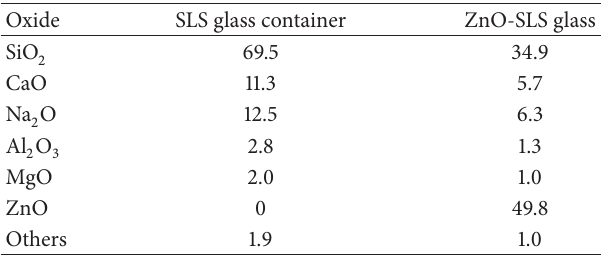
Table 1: Chemical composition of SLS glass waste and ZnO-SLS glass